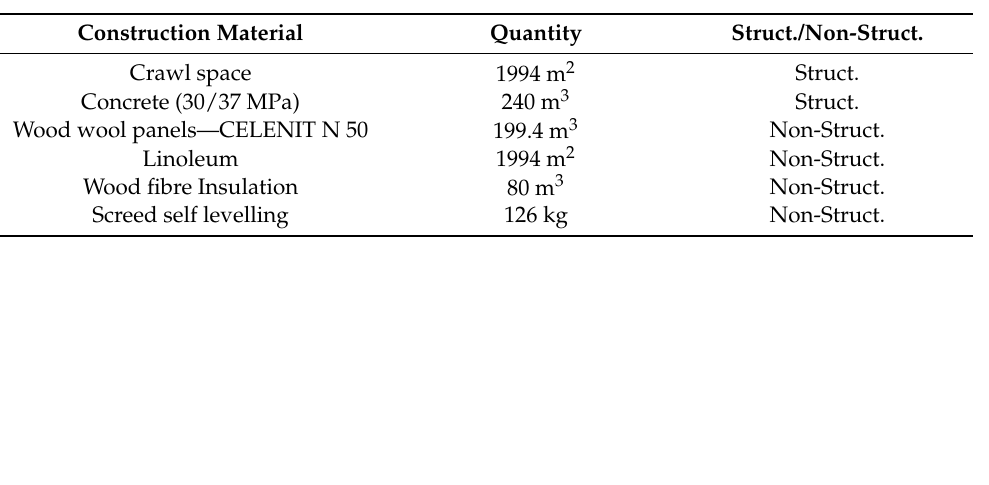
Table 4. Bill of materials: ground Table 3. Bill of materials: foundation.